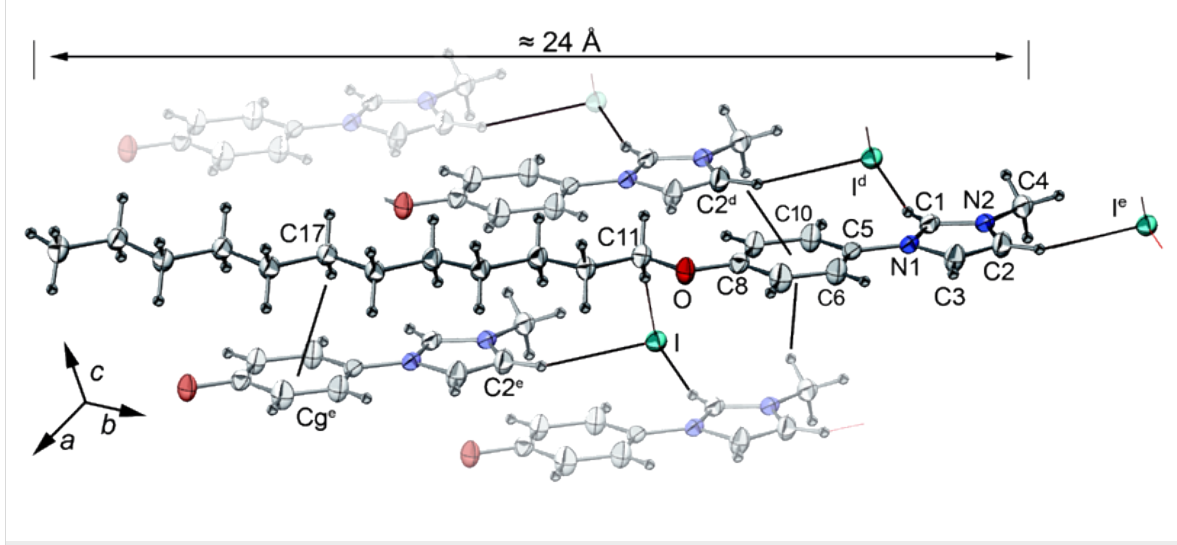
Figure 1: ORTEP view of compound 1a with partial labelling. The closest molecules are represented (with lower opacity) when connected by CH-π and/or non classical H-bonds (black thin lines). The ellipsoids enclose 50% of the electronic density. Symmetry operators for equivalent positions: